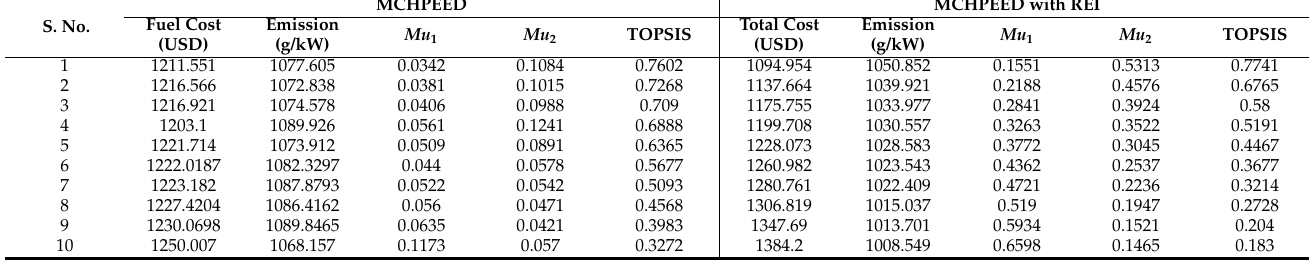
Table 8. Top ten optimal front solutions.